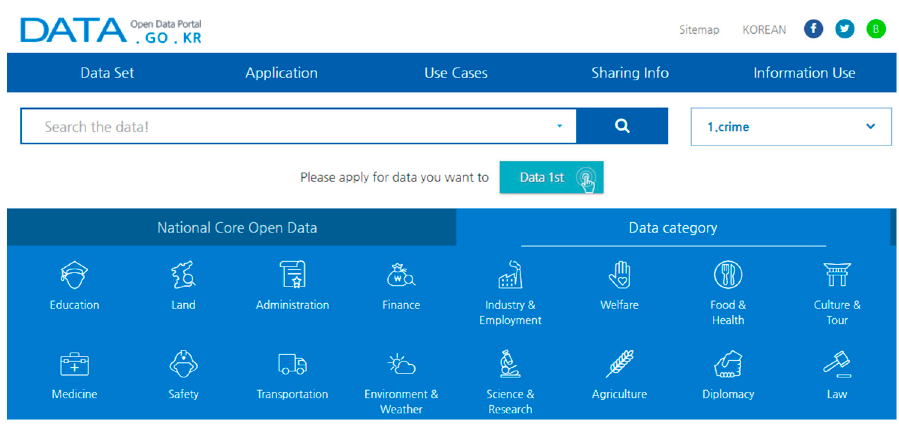
Figure 3. Public data portal site (OPEN API).